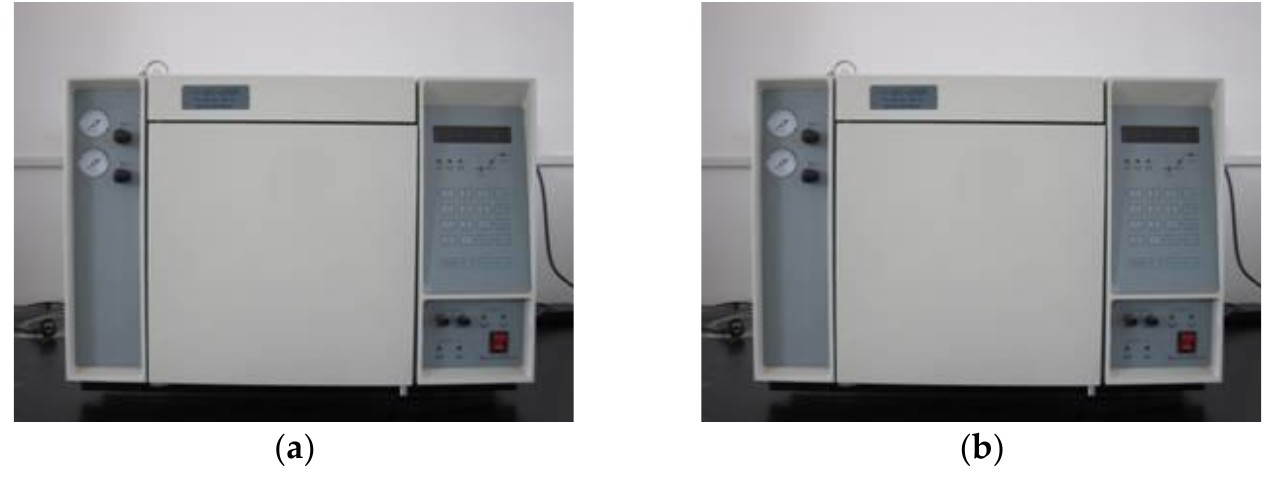
Figure 2. Experimental instrument diagram. ( a ) GC − 2000TCD gas chromatograph. ( b ) Delta V stable isotope mass spectrometer.